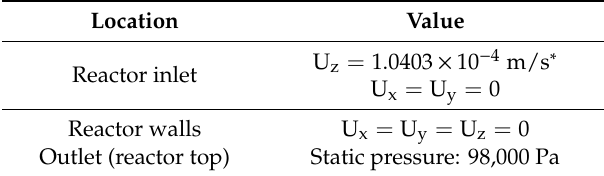
Table 1. Boundary conditions specified on the field of